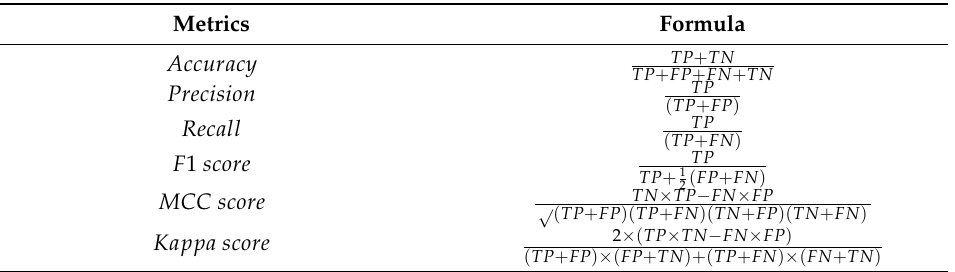
Table 2. Evaluation